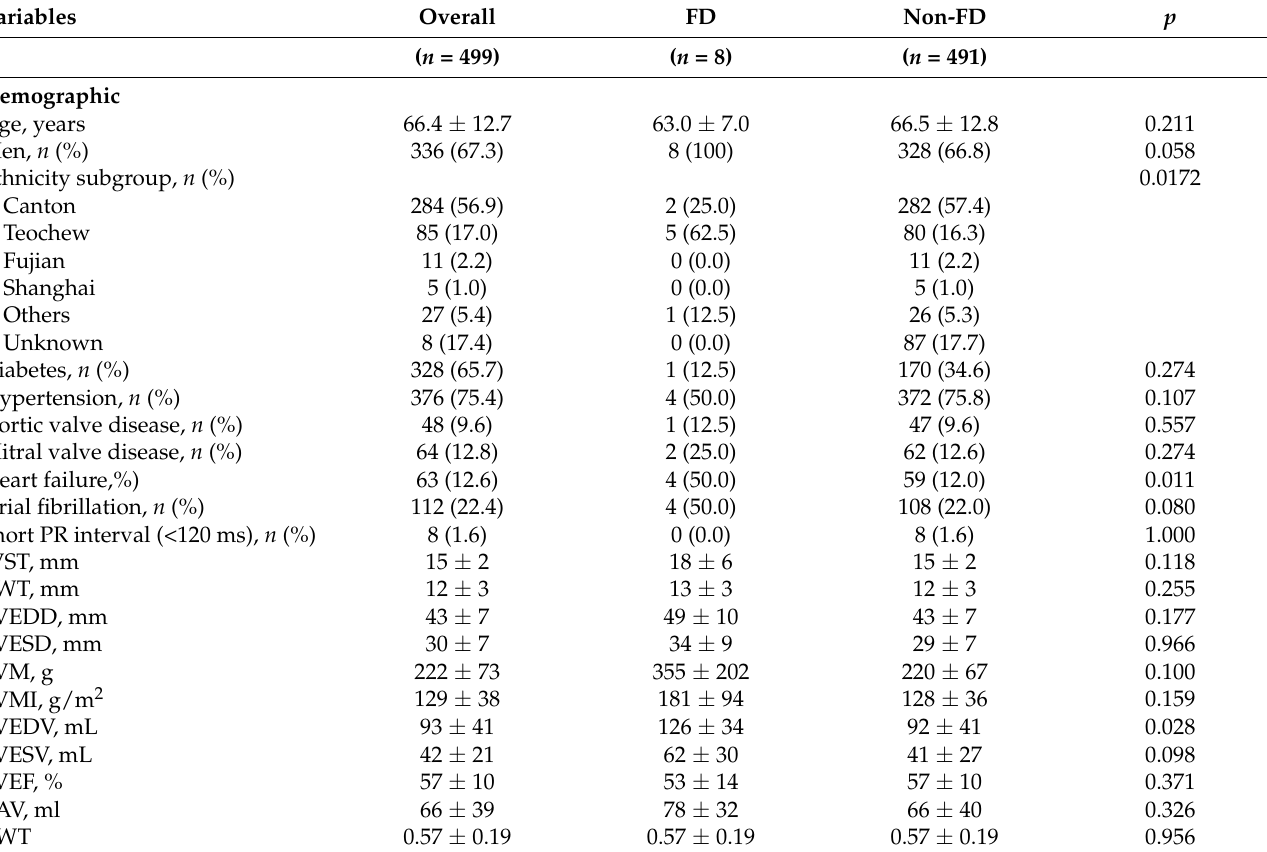
Table 1. Characteristics of the overall study population and comparisons between confirmed FD and non-FD patients.